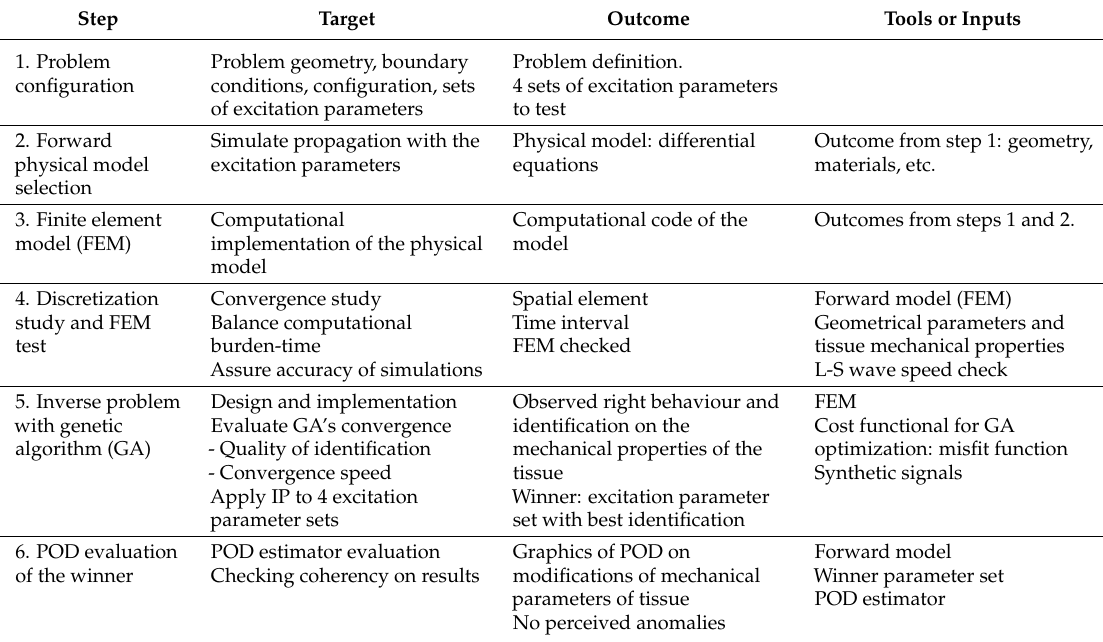
Table 1. Methodology of phase 1.